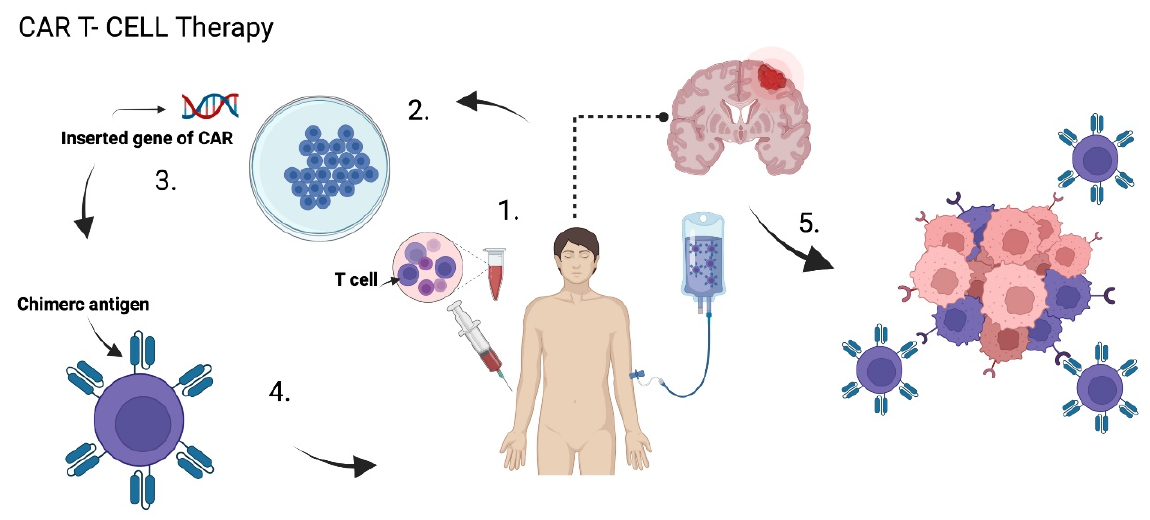
Figure 5. CAR T Cells Therapy. (1) T cells are extracted from the peripheral blood of patients, then (2) they are ex-vivo amplified and genetically remodeled so that (3) they express specific chimeric antigen receptor (CAR) in the cell membrane. (4) CAR T cells are injected back again in the patient, which can (5) specificallyrecognize the tumor cells and induce apoptosis. Created with BioRen- der.com.